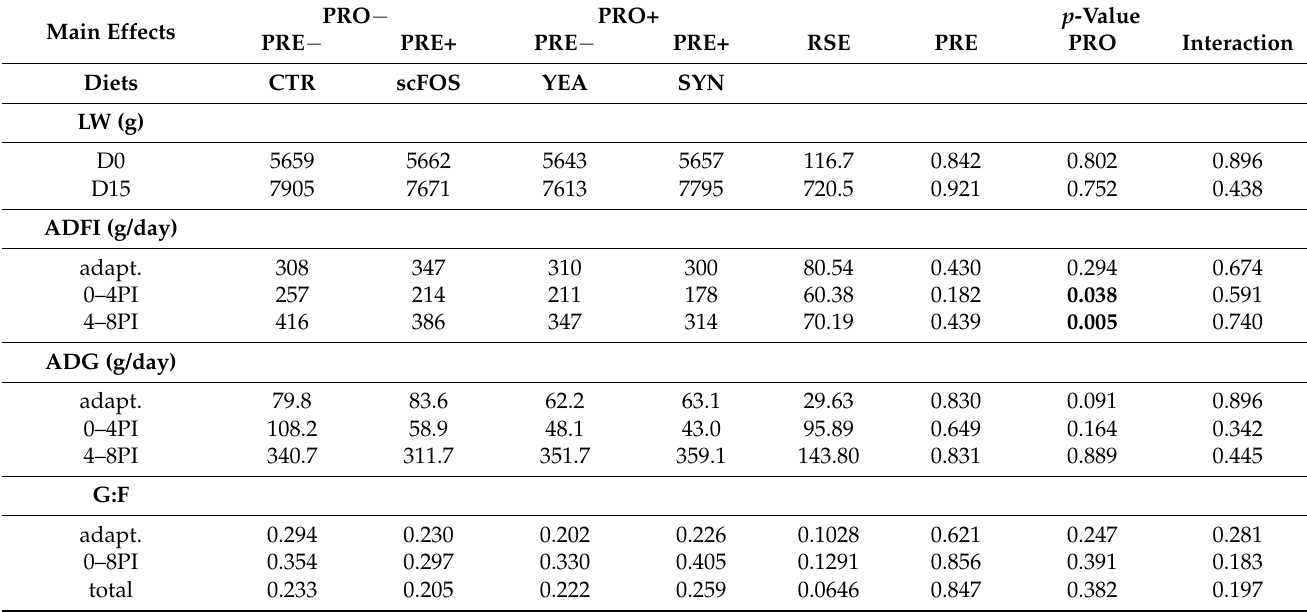
Table 2. Effect of experimental treatments on animal performance. LW (g), ADFI (g/day), ADG (g/day), and G:F for adaptation period (days 1–7), first post-inoculation (PI) period (days 0–4PI), second PI period (days 4–8PI).